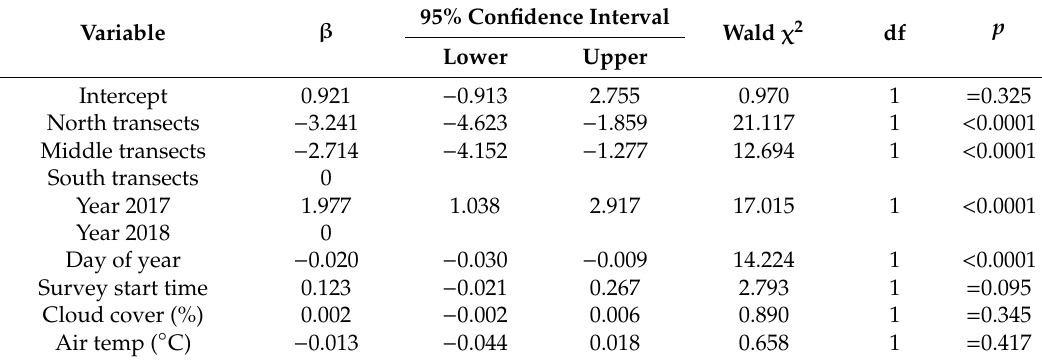
due to their inclusion in the intercept of the model.